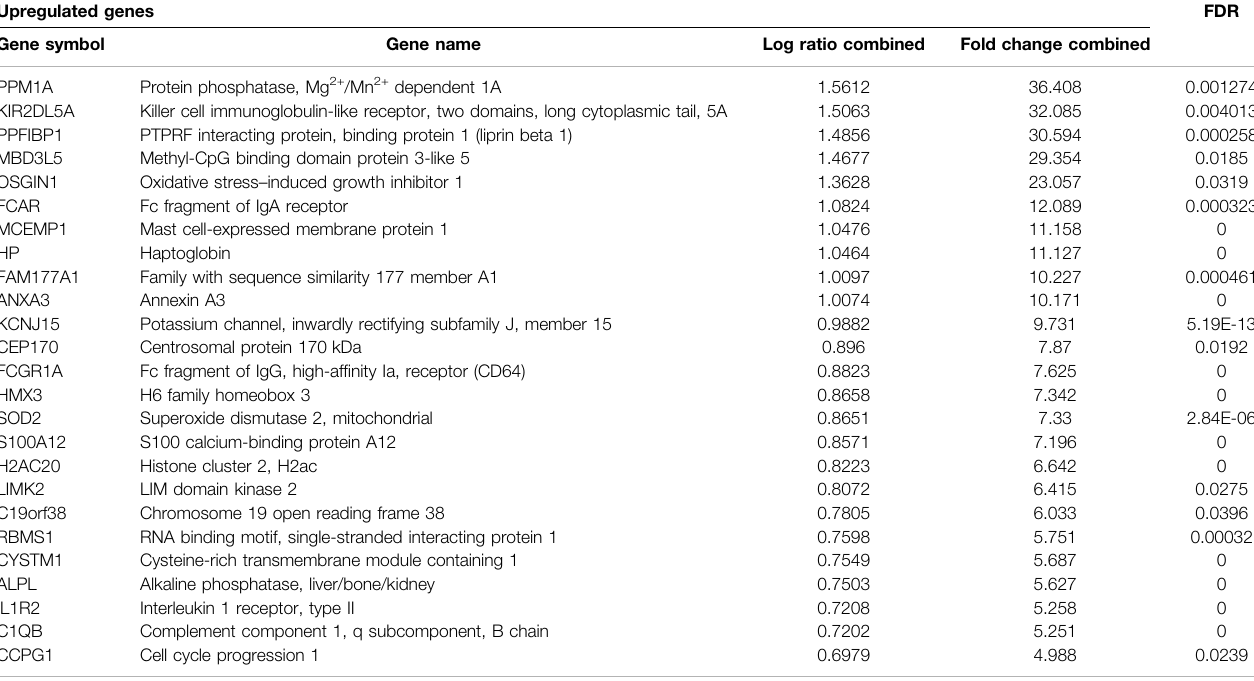
TABLE 3 | Top 25 upregulated genes of the microarray meta-analyses along with their fold change values. Upregulated